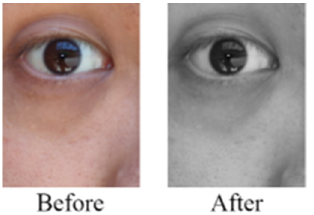
Figure 6. Grayscale operation on one of the captured images.